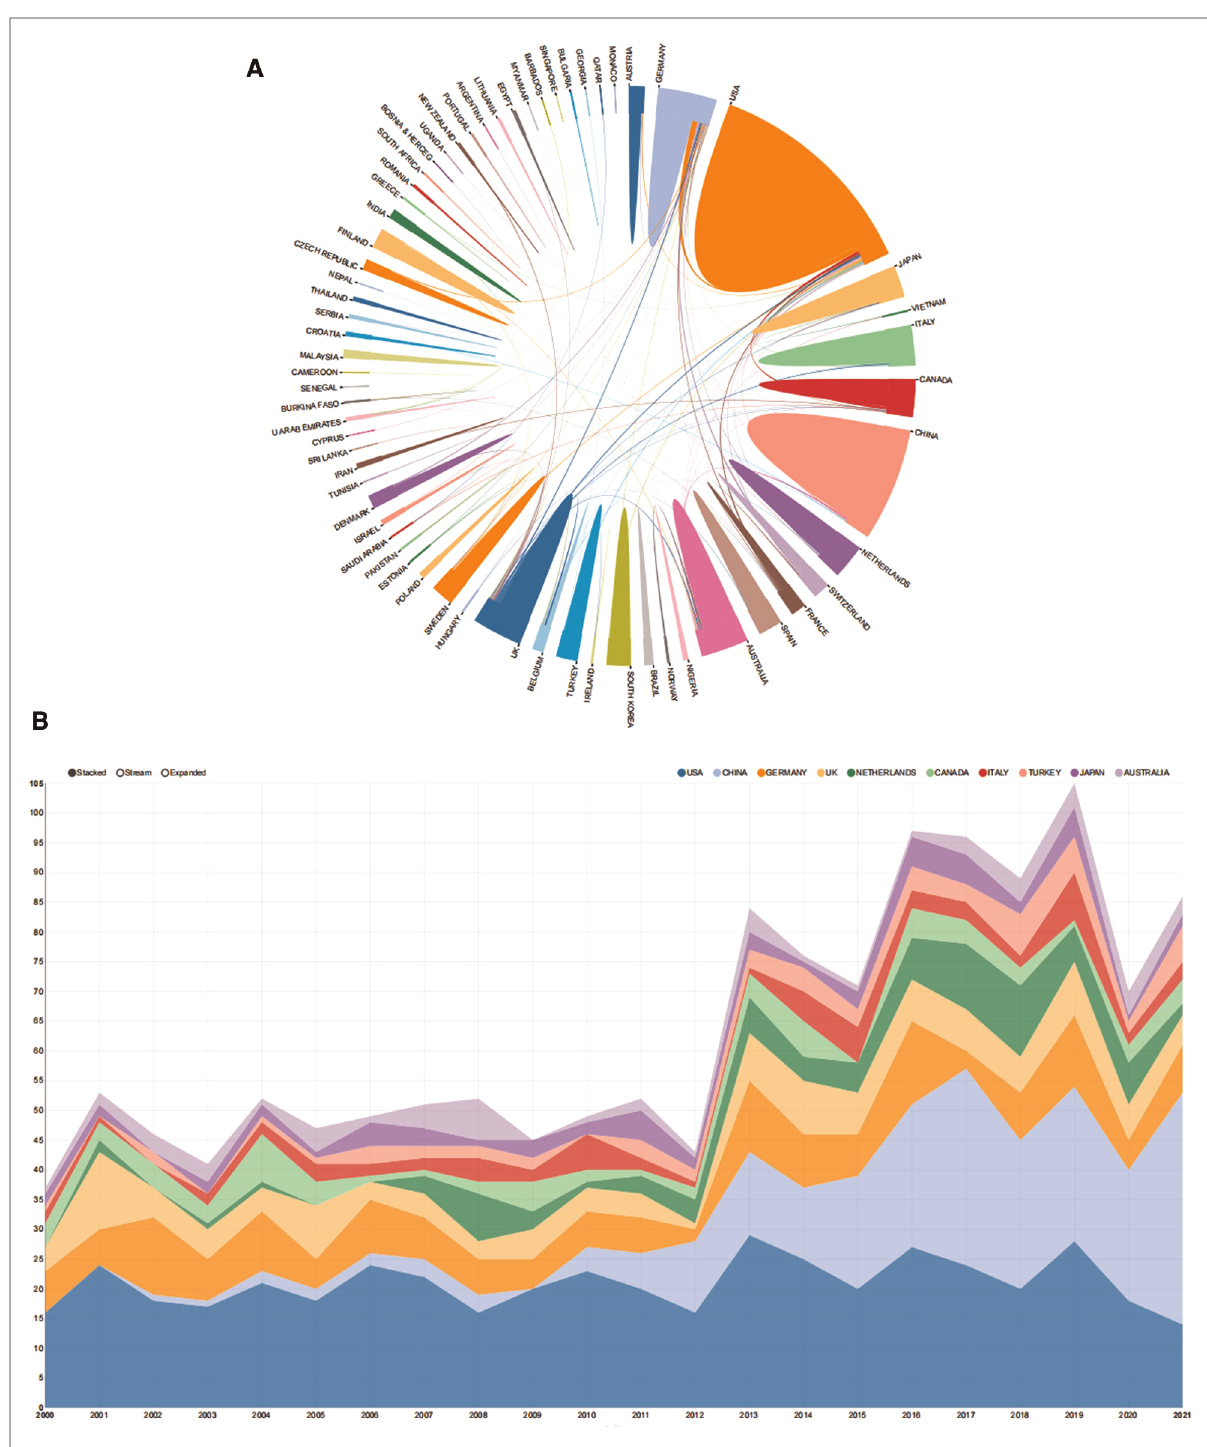
FIGURE 3 The top countries contributing to calcaneal fracture research. ( A ) Cooperation map of the countries and regions involved in calcaneal fracture research. The colored areas indicate the number of articles published by each country or region. The larger the area, the greater the number of articles. The lines represent the collaborative relationships between countries; thicker lines indicate a closer relationship. This map was generated from an online analysis platform (https://bibliometric.com). ( B ) Publication trends of the 10 countries most active in calcaneal fracture research between 2000 and 2021. The width of each colored area re fl ects the changes in publication trends among the different countries across the